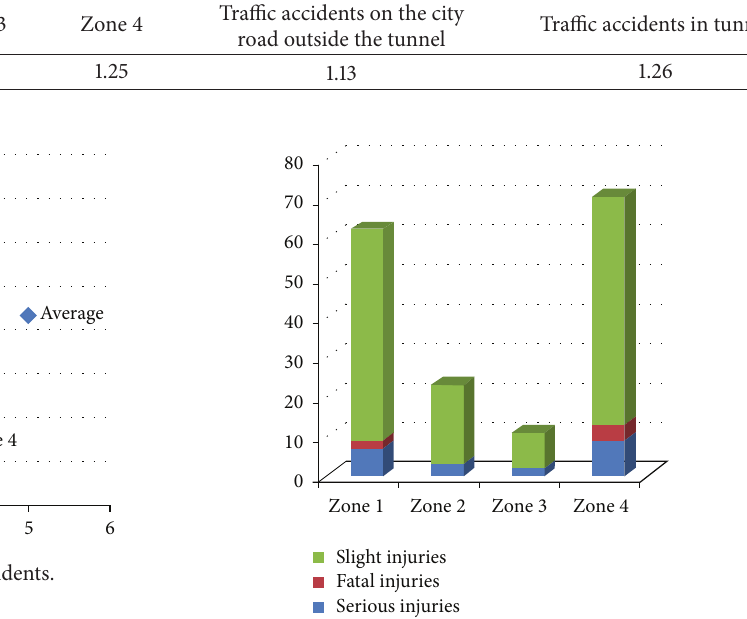
Figure 7: Number injured by severity and tunnel